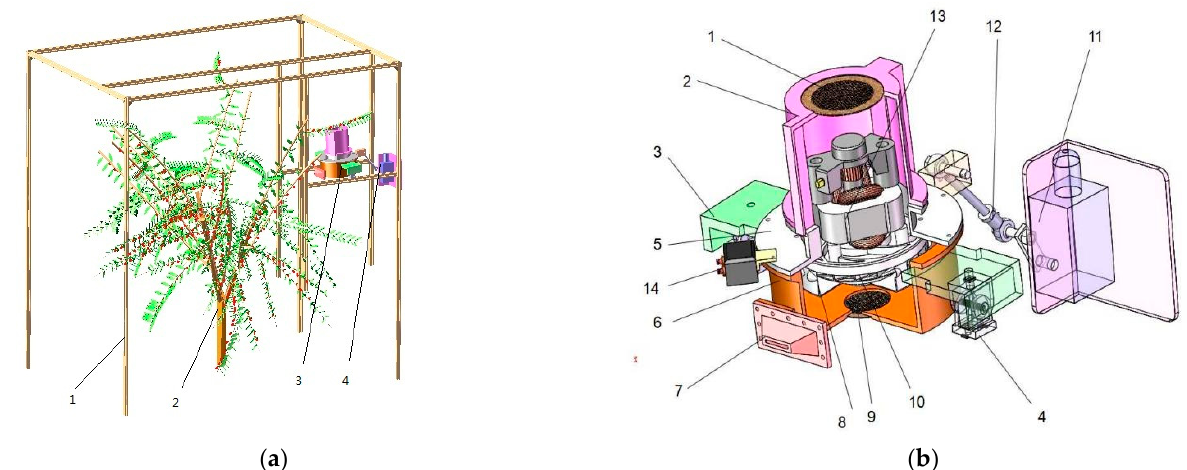
Figure 1. Structure of the proposed pneumatic oscillating Chinese wolfberry harvester: ( a ) field view. 1. support 2. plant to be harvested 3. air source device 4. swing device; ( b ) cutaway view. 1. fan cooling filter 2. upper cover of fan 3. fixed plate of fan 4. hinge 5. lower cover of fan 6. worm shell 7. fan outlet 8. fan cover 9. air inlet filter 10. fan blade 11. gear motor 12. four-rod mechanism 13. excitation motor 14. governor.